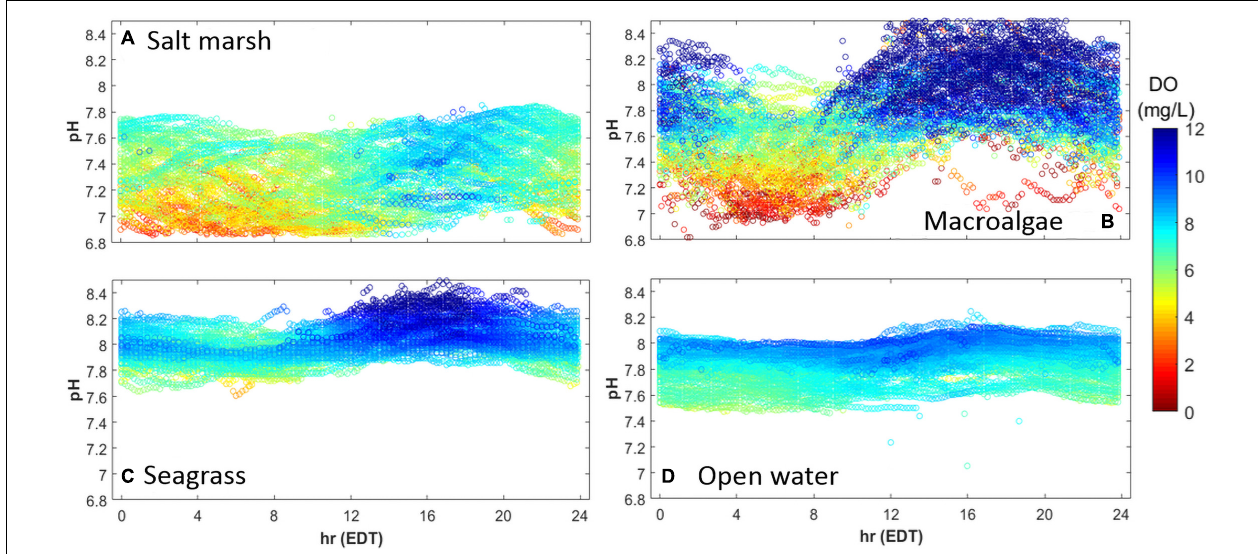
FIGURE 4 | Diurnal patterns of pH T (y-axis) and DO (mg L − 1 ; color) in an (A) salt marsh, (B) macroalgal dominated ( Ulva sp.) region, (C) seagrass meadow, and (D) open water estuary, May–October, 2015. Sites identical to Figure 3 .